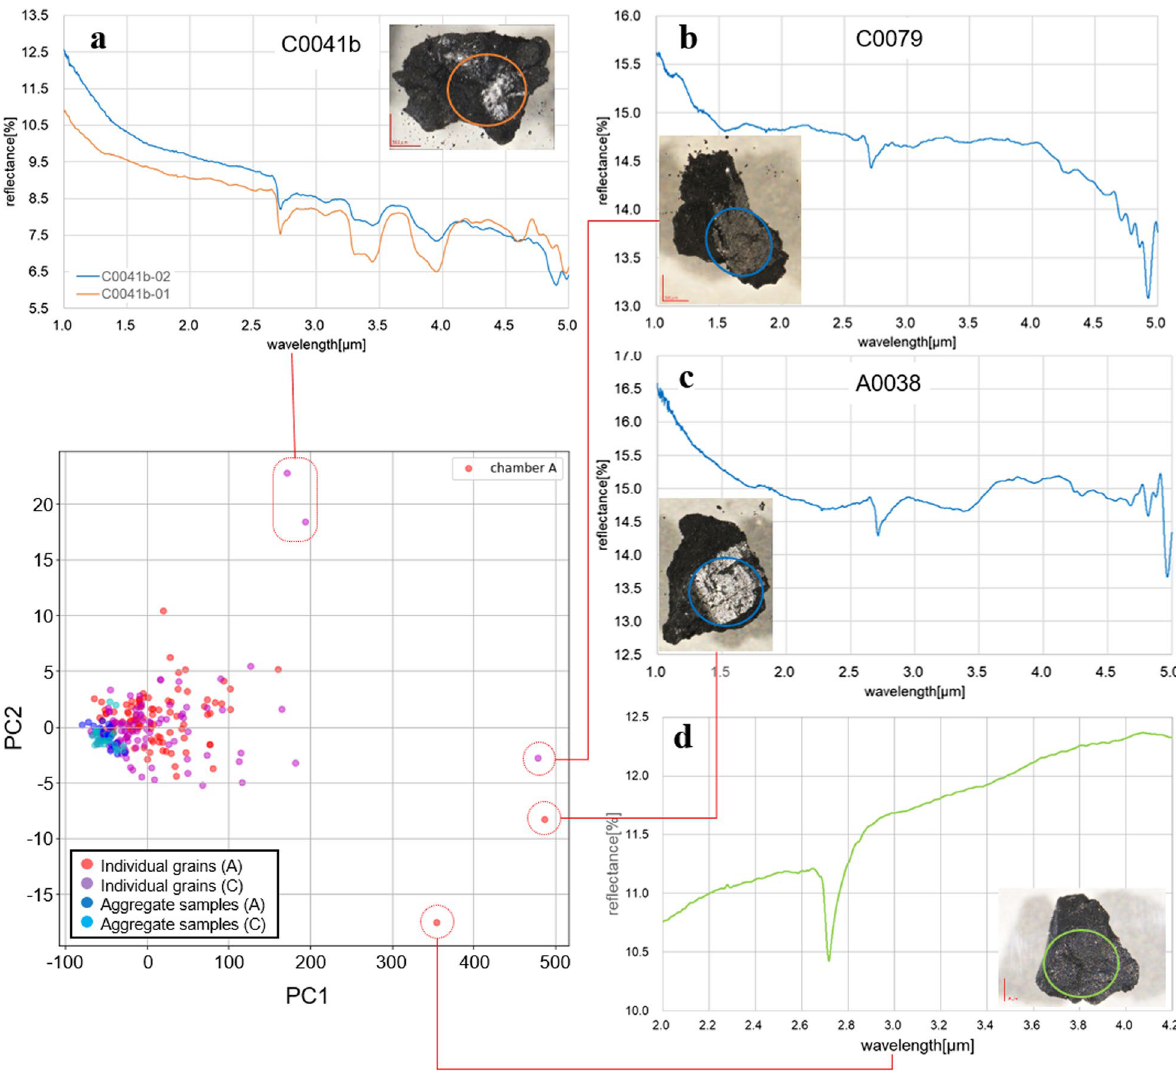
Fig. 11 Rarely detected unique spectra in individual grains: a C0041b, large carbonate inclusion, b , c C0079 and A0038, high reflectance with metallic inclusion, d C0054, high reflectance with specular reflection. The enclosed areas in the optical microscope images indicate the beam